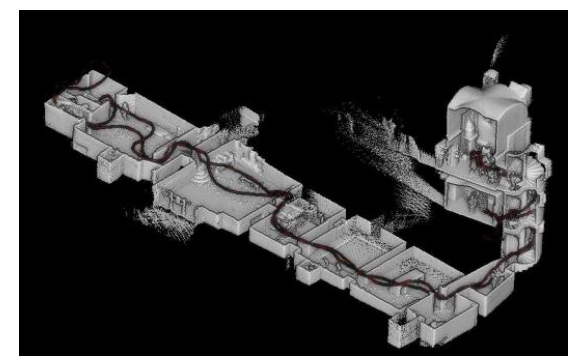
Figure 3. Photogrammetric point cloud